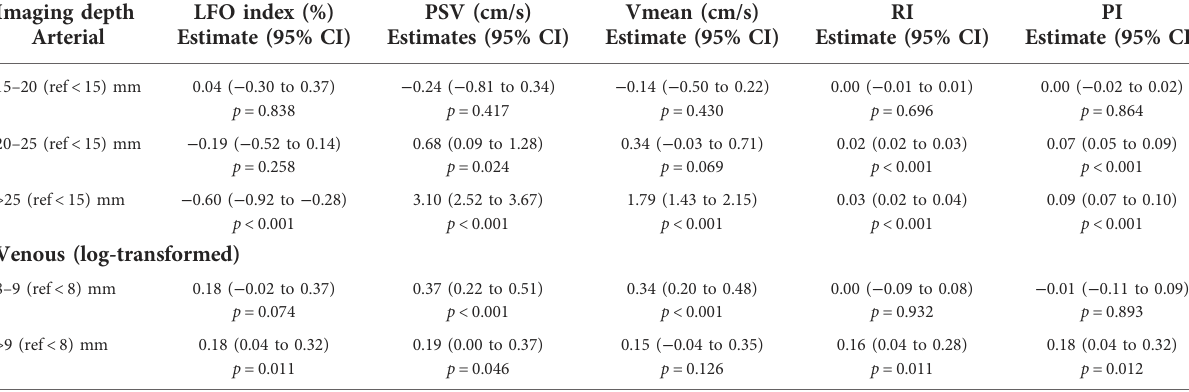
TABLE 4 Results from a linear mixed model to evaluate the association between cerebral hemodynamics and depth of the measurement. Imaging